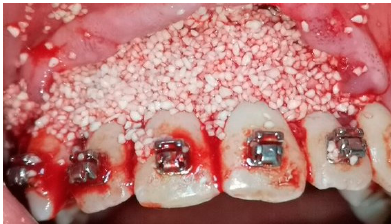
Figure 3. Bone augmentation with mineralized bone.